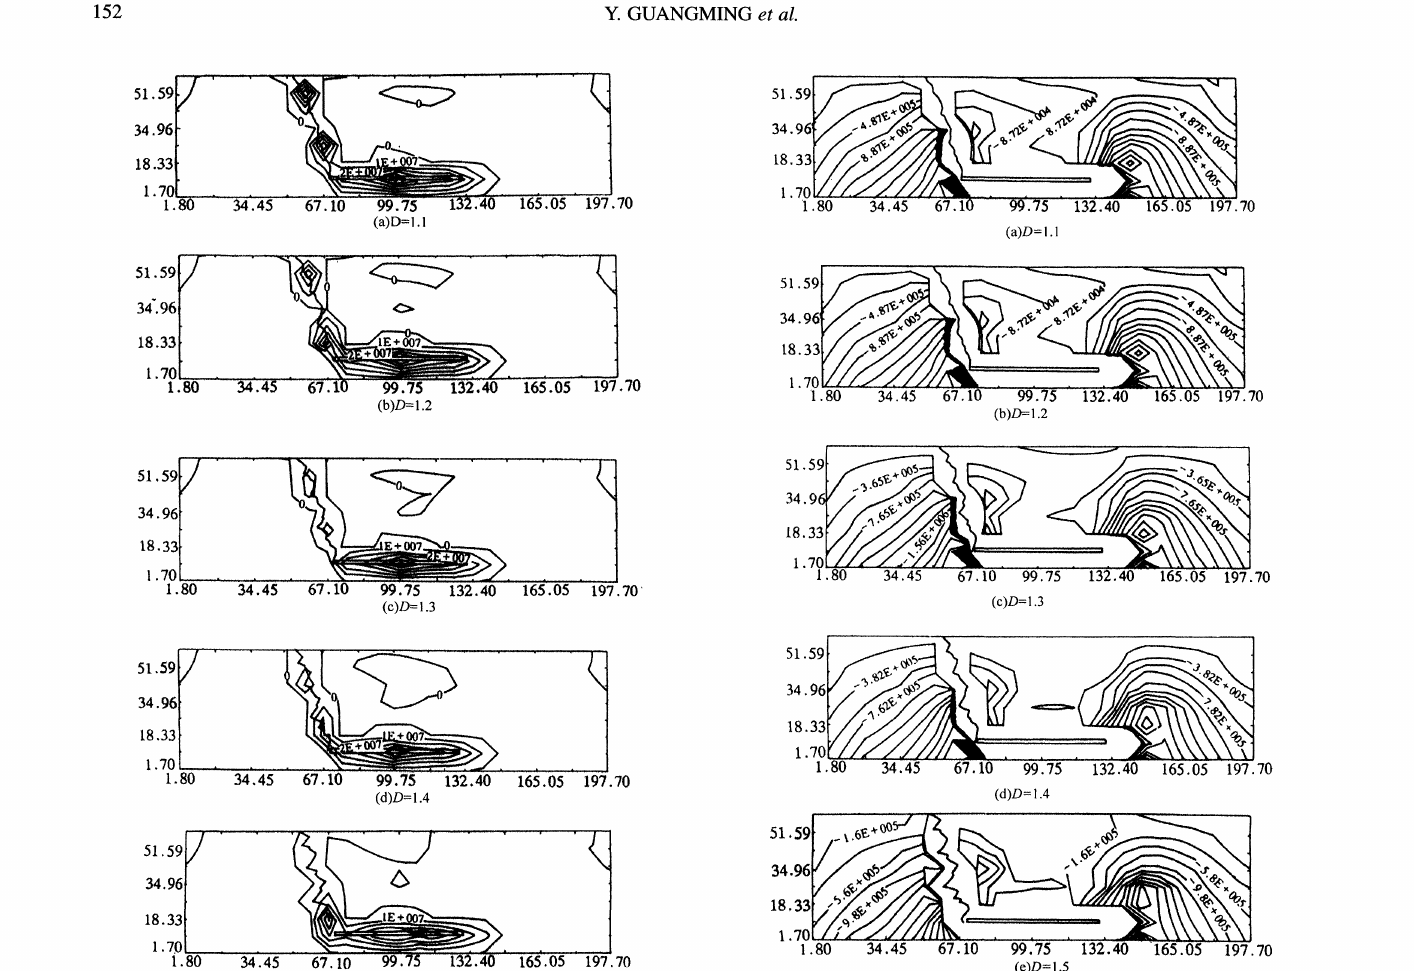
FIGURE 2 Distribution of compressive stresses in Y direction. In this figure, the unit of stress is: 105 Pa. lead to activation of fault surface, the stress distribution and overburden disruption conditions of all the five models are basically the same, that is to say, in the overburden close to the goaf there are two-way tensile disruption, and caving zone is formed and develops upward to become one-way (vertical) tension, thus it is easy to result in separation